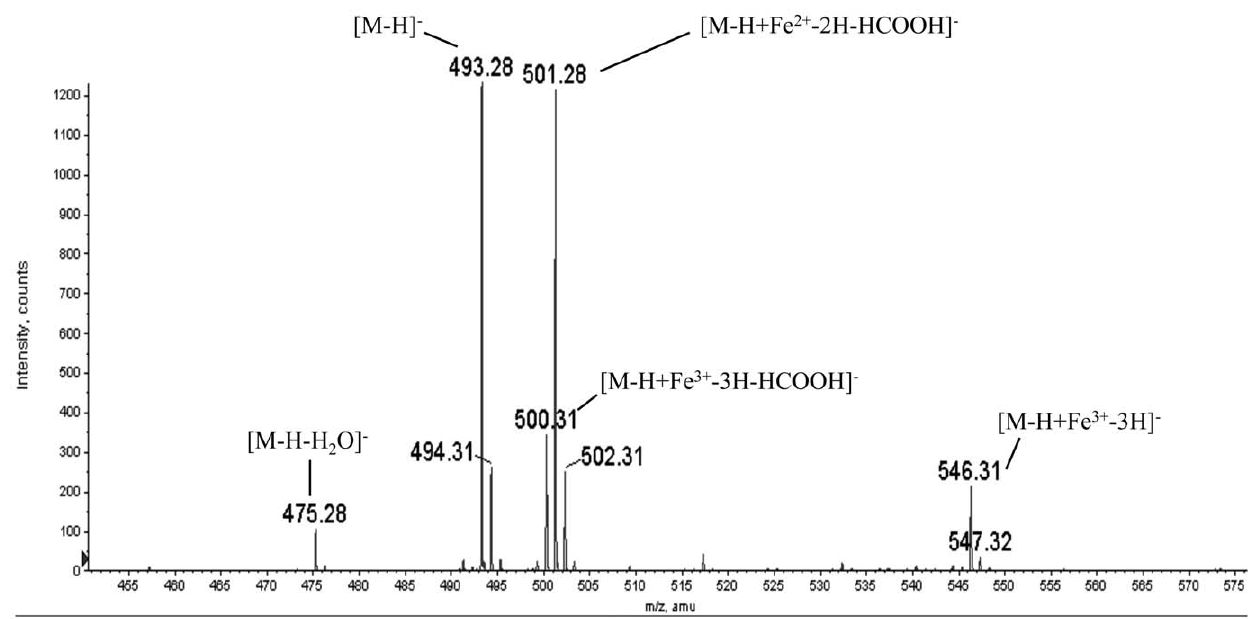
Figure 6. Analysis of corynebactin by electrospray ionization mass spectra (negative ion mode). A. A representative mass spectrum for corynebactin. The average m/z value for corynebactin was 493.138 based on the average of five separate mass spectra. Additional peaks at 475.28, 500.31, 501. 28, and 546.31 correspond to the following ions: [M-H-H 2 O] 2 , [M-H + Fe 2 + -2H-HCOOH] 2 , [M-H + Fe 3 + -3H-HCOOH] 2 , and [M-H + Fe 3 + -3H] 2 , respectively.